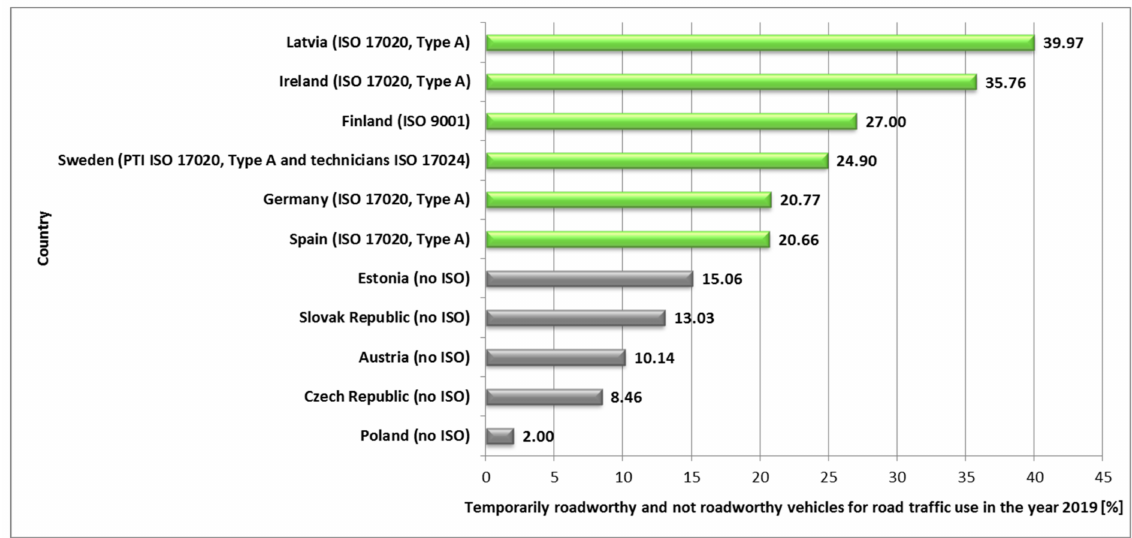
Figure 2. Average results of assessments of the technical condition of vehicles in selected countries of the European Union and the obligation of certification or accreditation at the PTI.